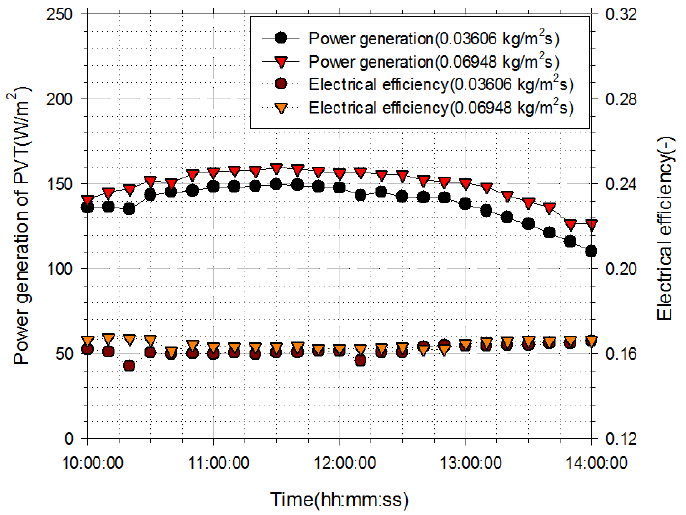
Figure 6. Power generation and electrical efficiency of the PVT air collector during test period.